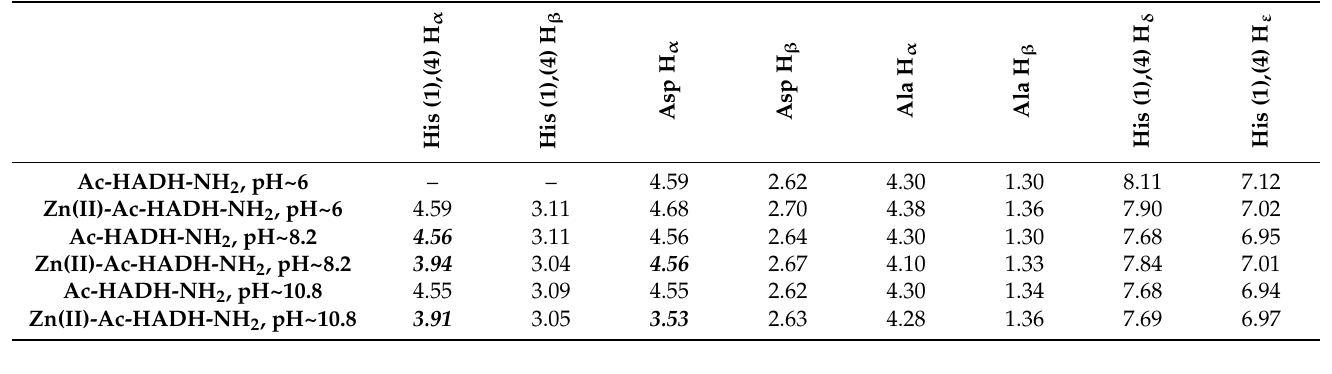
Table A5. Characteristic 1 H NMR spectral parameters (medium values, ppm) of the Ac-HADH-NH 2 ligand and zinc(II) containing system (Zn(II):L = 1.2:1, c L = 5 mM).